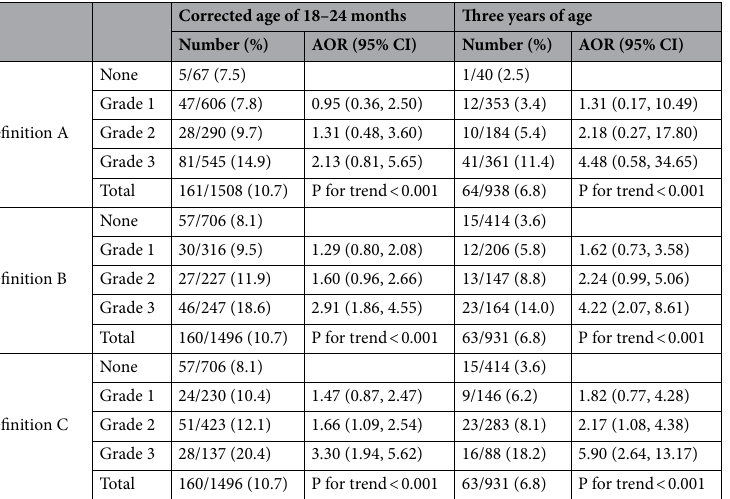
Table 2. Respiratory morbidities at a corrected age of 18–24 months and at 3 years of age according to the severity of bronchopulmonary dysplasia per each definition. AOR adjusted odds ratio; CI , confidence interval. ORs were adjusted for antenatal steroids therapy, surfactant use, gestational age, small for gestational age, intraventricular hemorrhage (≥ grade 3), periventricular leukomalacia, necrotizing enterocolitis (≥ stage 2), retinopathy of prematurity (requiring surgery), and sepsis using multivariable logistic regression. Respiratory morbidities were defined as (1) death due to respiratory causes from 36 weeks’ postmenstrual age prior to follow-up 1 or between follow-ups 1 and 2; (2) (2) more than two readmissions due to respiratory causes between discharge from the neonatal intensive care unit and follow-up 1 or between follow-ups 1 and 2; or